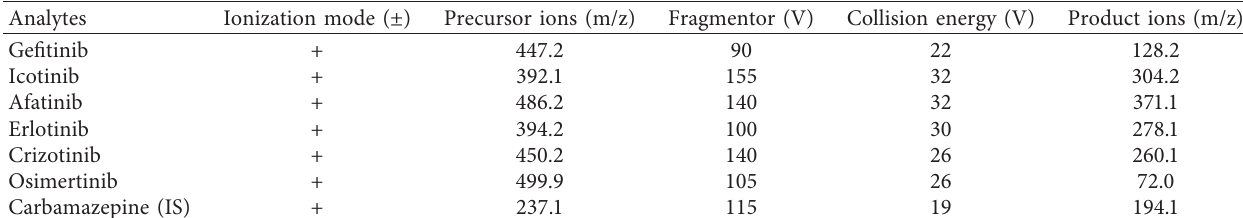
Table 1: Optimized mass spectrometry parameters of six analytes and IS.